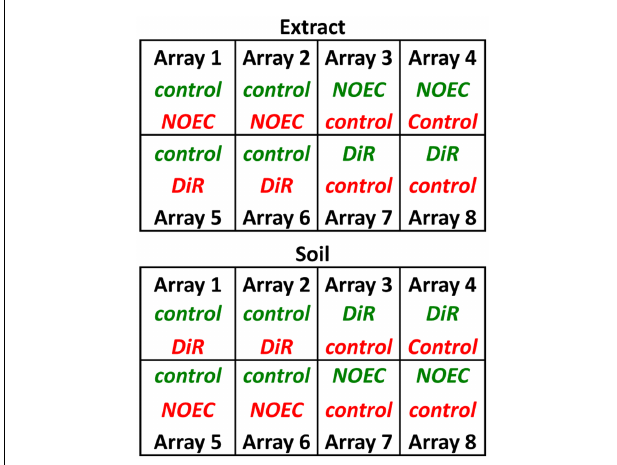
FIGURE 1 | Hybridization scheme for gene expression analysis. On each of the arrays, a test sample (NOEC or DiR) of either Soil or Extract is hybridized against a control sample (Lufa 2.2 for Soils; acetone spiked-in Lufa 2.2 for extracts). Green Cy-3, Red